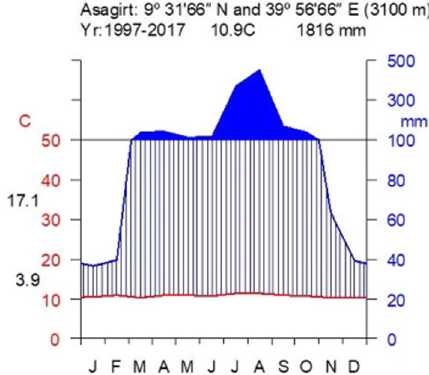
Fig. 2 Climatic diagram showing mean annual temperature and rainfall from 1997 to 2017 (Data source: National Metrological Services Agency,